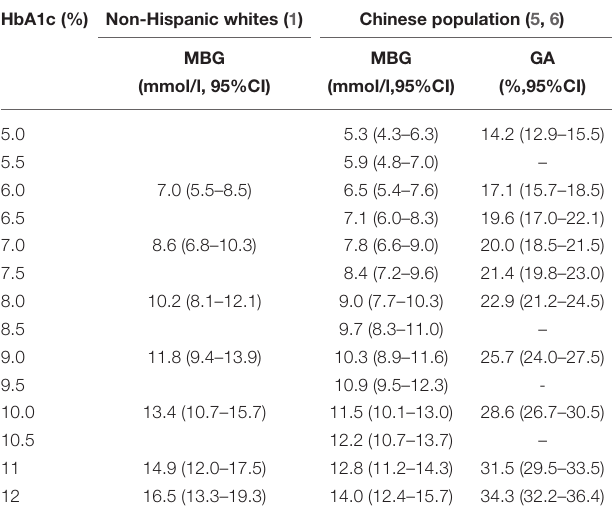
is associated with dehydration hereditary stomatocytosis (DHS). TABLE 2 | Mean glucose levels for specified HbA1c and GA